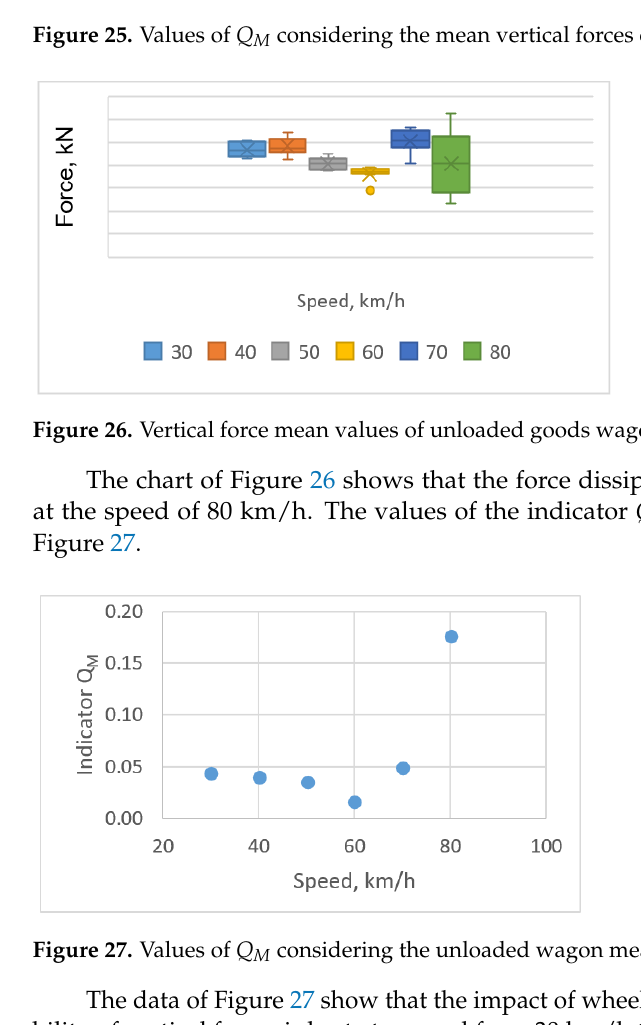
Figure 27. Values of Q M considering the unloaded wagon mean vertical forces.